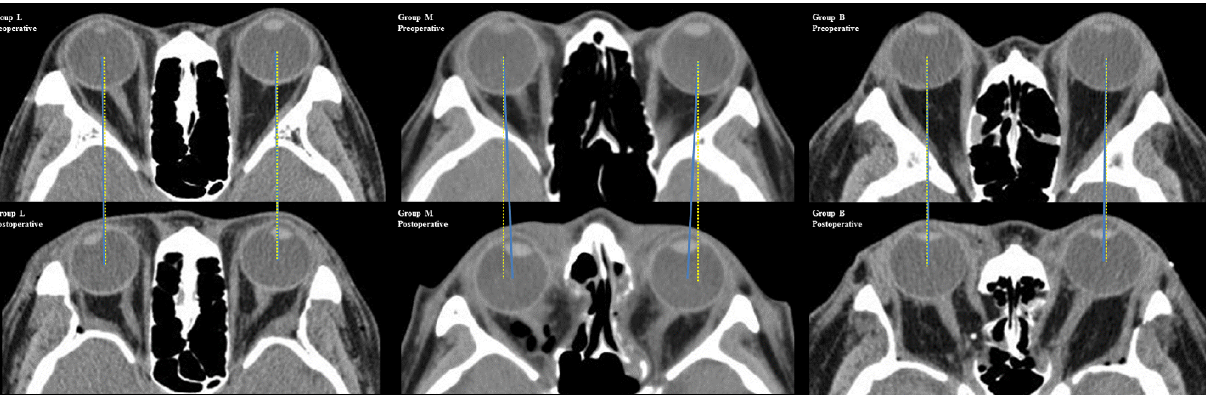
Figure 2. Axial computed tomographic (CT) images of the orbit before and after orbital decompression, in each group. The preoperative CT images have the same size as the postoperative images. The blue solid lines are connecting the center of the eyes, preoperatively and postoperatively, and the yellow dotted lines are perpendicular lines. In Group L (left), the eyes shifted slightly laterally after the lateral orbital wall decompression. In Group M (center), the eyes shifted medially after the medial orbital wall decompression. In Group B (right), the eyes shifted slightly medially after the balanced orbital decompression.